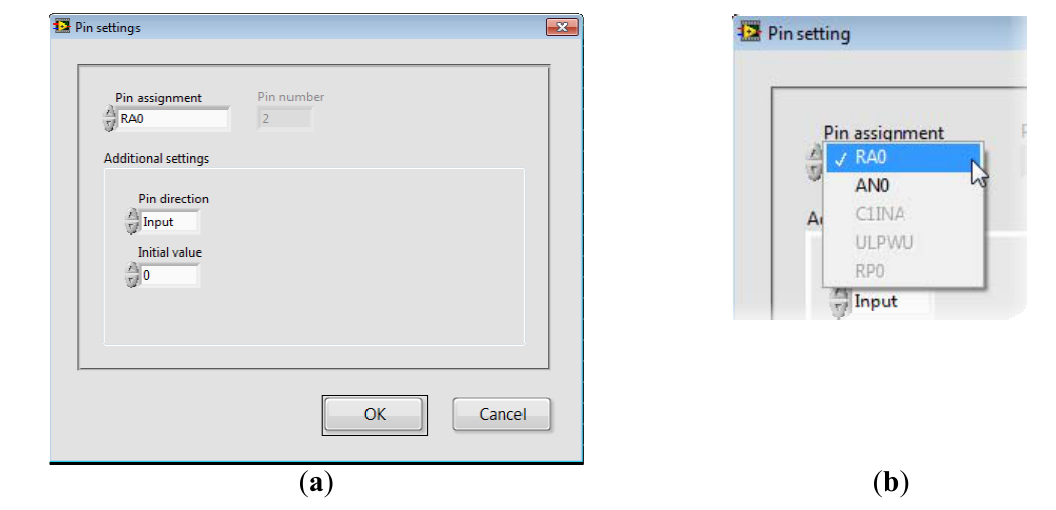
Figure 9. ( a ) Pin settings window ( b ) Pin assignment